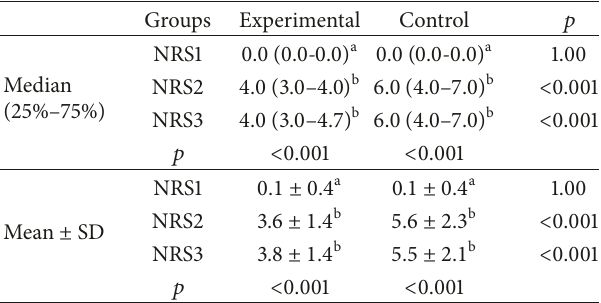
Table 4: Comparison of NRS scores of the patients in the experi- mental and control